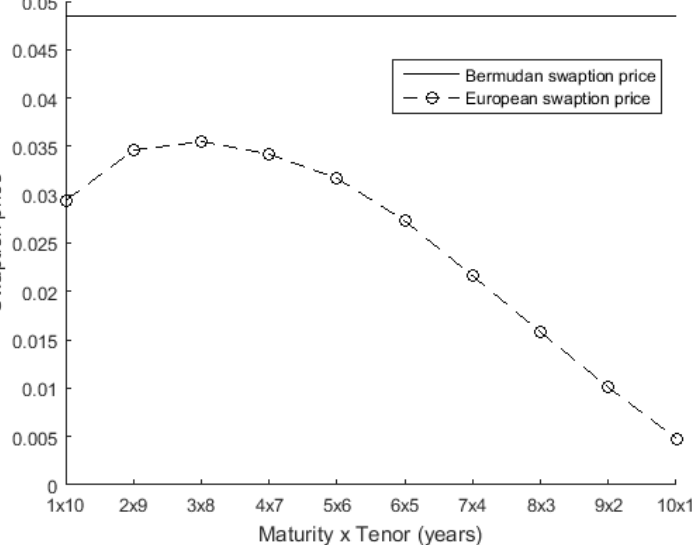
Figure 2. Price of a 11nc1 Bermudan receiver swaption plotted against the prices of co-terminal Europeans (all options struck at K =